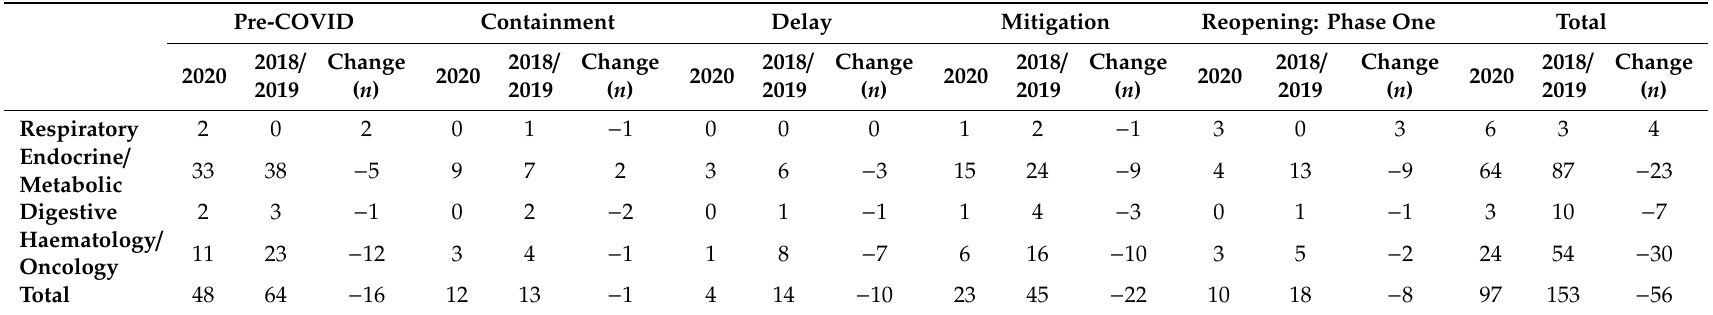
Table 4. Paediatric emergency department attendance for Complex Chronic Conditions by public health COVID-19 response stage: (Dublin only). Pre-COVID Containment